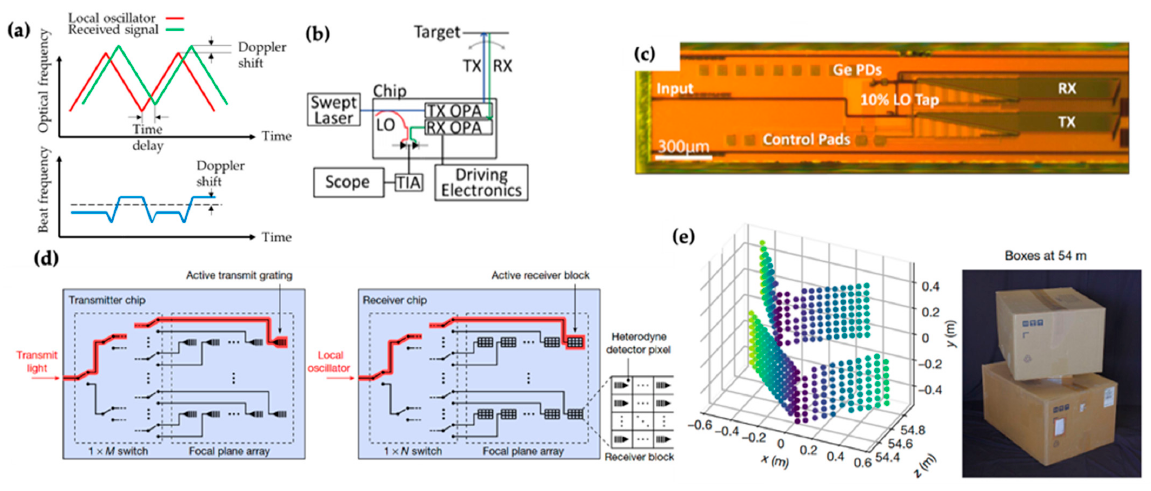
Figure 8. ( a ) Operation principle of the FMCW ranging technique. ( b , c ) Schematic and device optical image of an OPA-based FMCW LiDAR system. Reprinted with permission from [6] © The Optical Society. ( d , e ) Schematic and measured point cloud of an FPA-based FMCW LiDAR system. Another schematic of this system is shown in Figure 6d. Reprinted with permission from Springer Nature: Nature [7], © Springer Nature (2021).